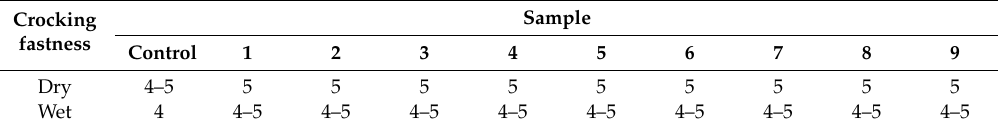
Table 5. Crocking fastness rating of 1 g/L pigment-dyed cotton samples.